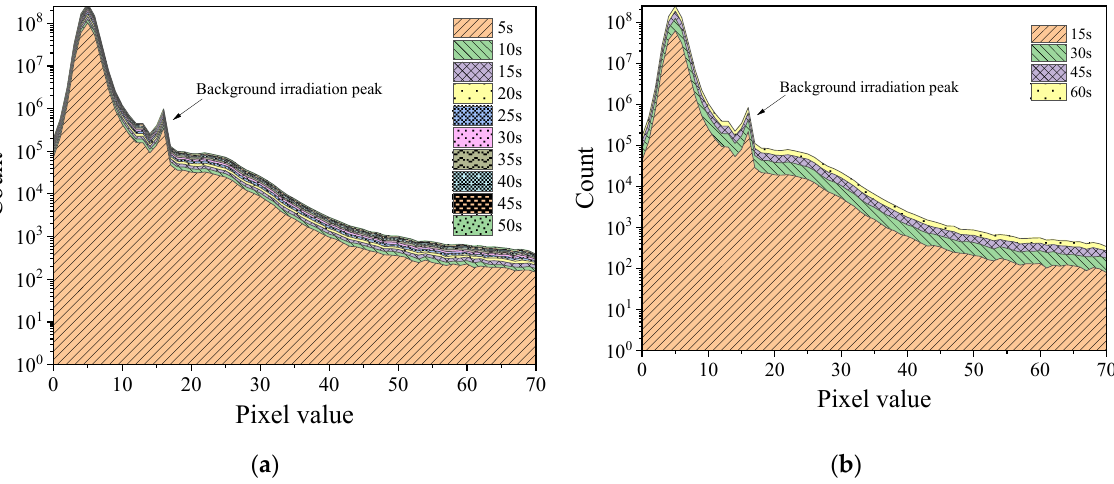
Figure 7. Histogram of mixed radiation field of Am-Be source and 137 Cs source at 1.04 mGy/h (24 frames per second). ( a ) Stack once every 5 s. ( b ) Stack once every 15 s.